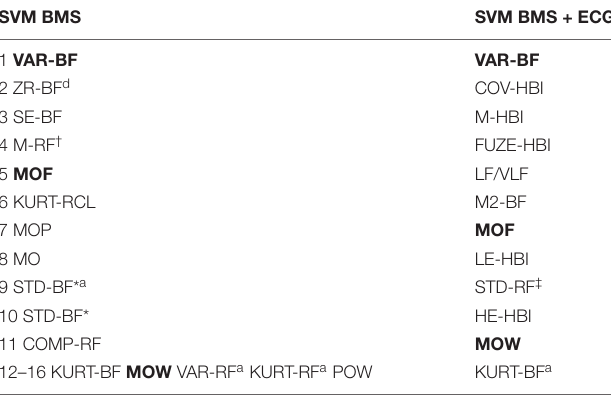
TABLE 3 | Selected features for BMS and BMS + ECG-based SVMs. SVM